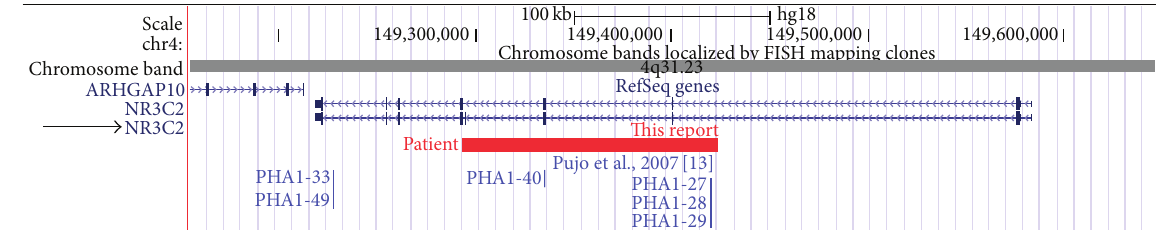
Figure 2: Schematic of a deletion spanning exons 3–5 in our patient (as shown in red bar) compared to other single exons deletions detected by quantitative real-time PCR using exon-spanning primers (as shown in blue vertical line) in exon 3 (families PHA1-27, PHA1-28, and PHA1- 29), exon 4 (family PHA1-40), and exon 8 (families PHA1-33 and PHA1-49), as reported by Pujo et al. in 2007 [13]. Deletion map corresponds to NR3C2 isoform 1 (NM 000901.4), as indicated by black